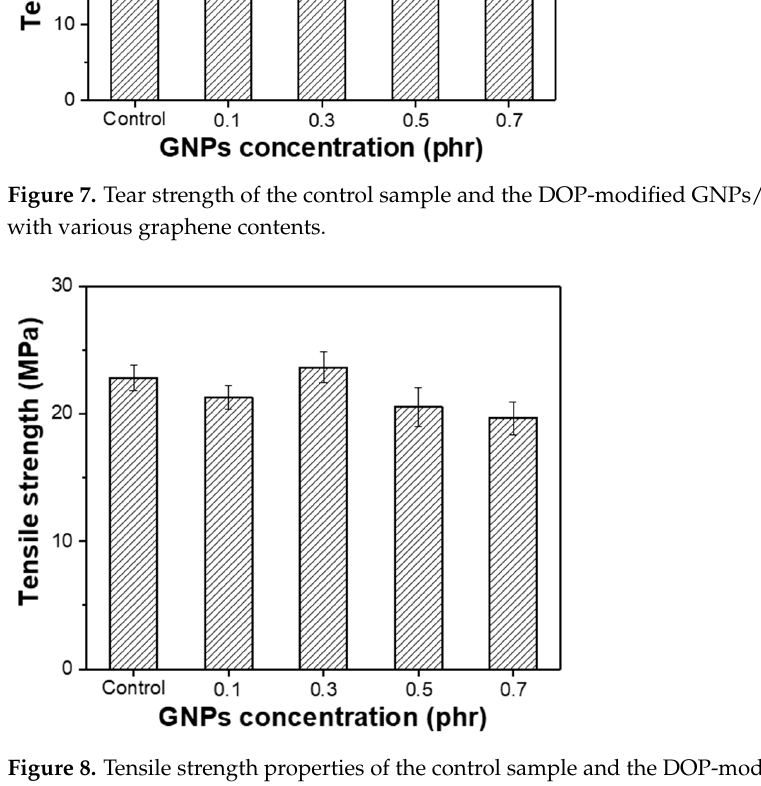
Figure 8. Tensile strength properties of the control sample and the DOP-modified GNPs/NR rubber composites with various graphene